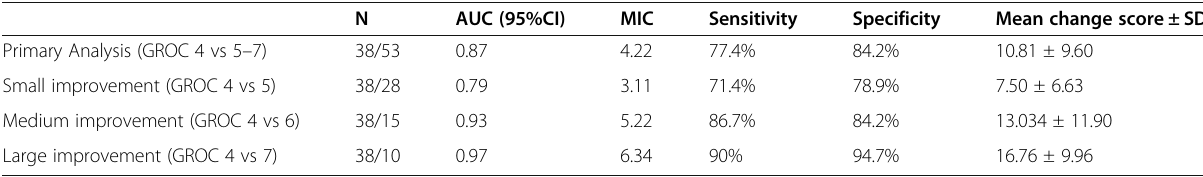
Table 4 Responsiveness of the NODI N AUC (95%CI) MIC Sensitivity Specificity Mean change score ± SD Primary Analysis (GROC 4 vs 5 – 7)